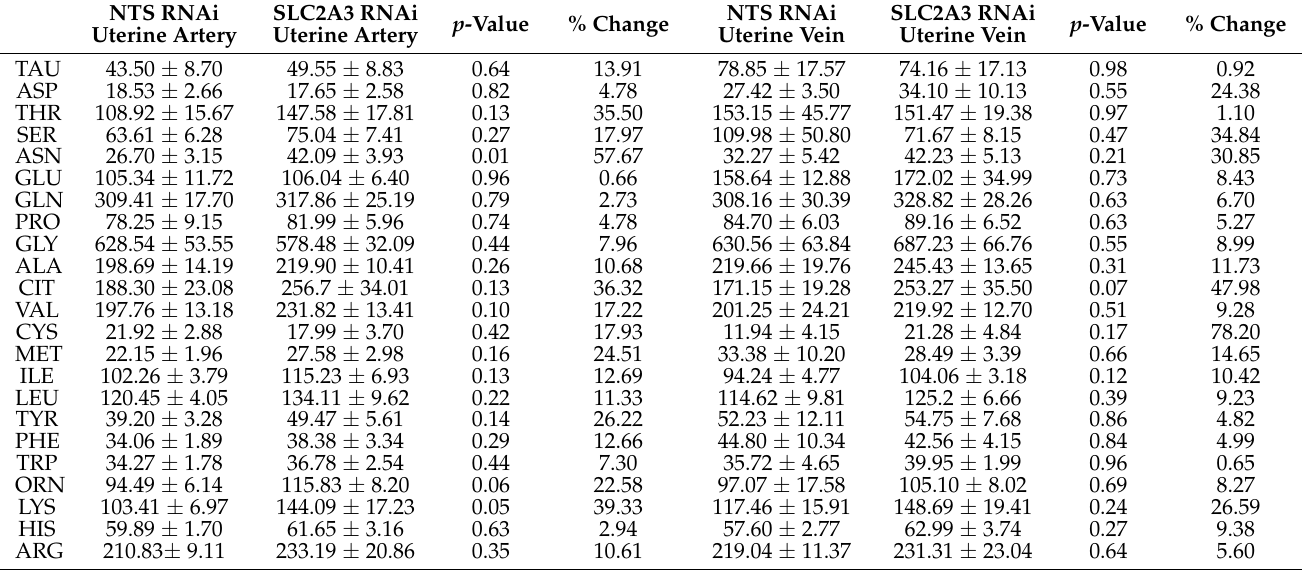
Table 3. Maternal plasma amino acid concentrations (75 dGA).